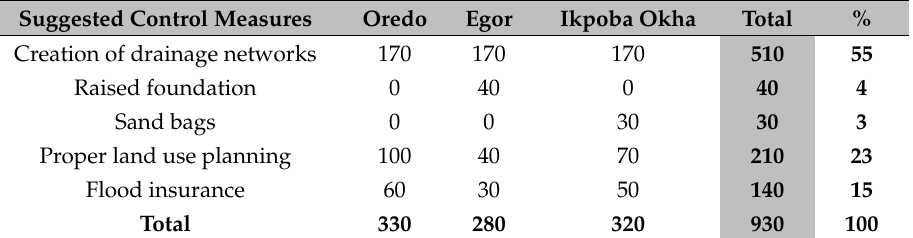
Table 6. Suggested flood control measures by